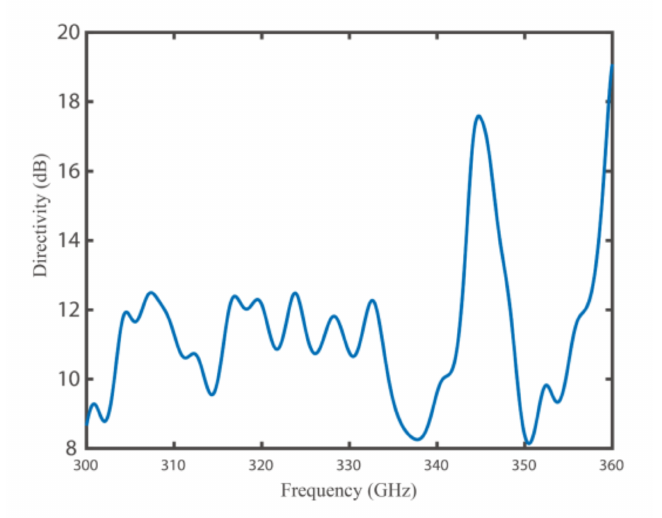
Figure 15. The directivity of the three-port directional coupler in the frequency band of 300–360